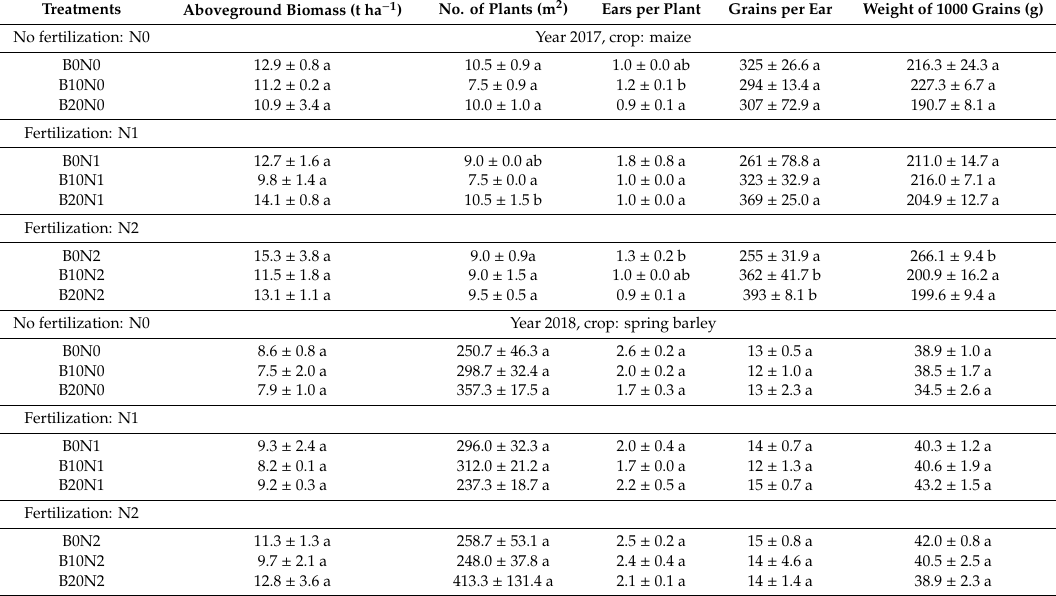
Table 5. The selected yield parameters of maize and spring barley in the third and fourth year after biochar application, respectively (means ± standard error; n = 3). Treatments Aboveground Biomass (t ha − 1 ) No. of Plants (m 2 ) Ears per Plant Grains per Ear Weight of 1000 Grains